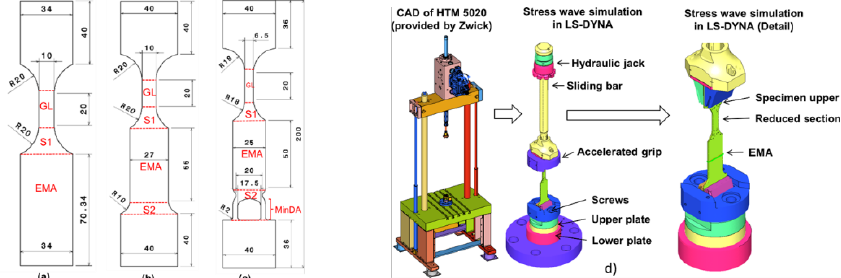
Figure 1: Geometry of tensile test samples a.) according to ISO 26203-2; b.) its modification as Generation I (Gen. I) sample and c.) further modification as Generation III (Gen. III) sample. EMA: elastic measurement area for strain gauge to measure the force; MinDA: minor deformation area; S1: first shoulder; S2: second shoulder, GL: gauge length of plastic deformation; d) FE-model of the test